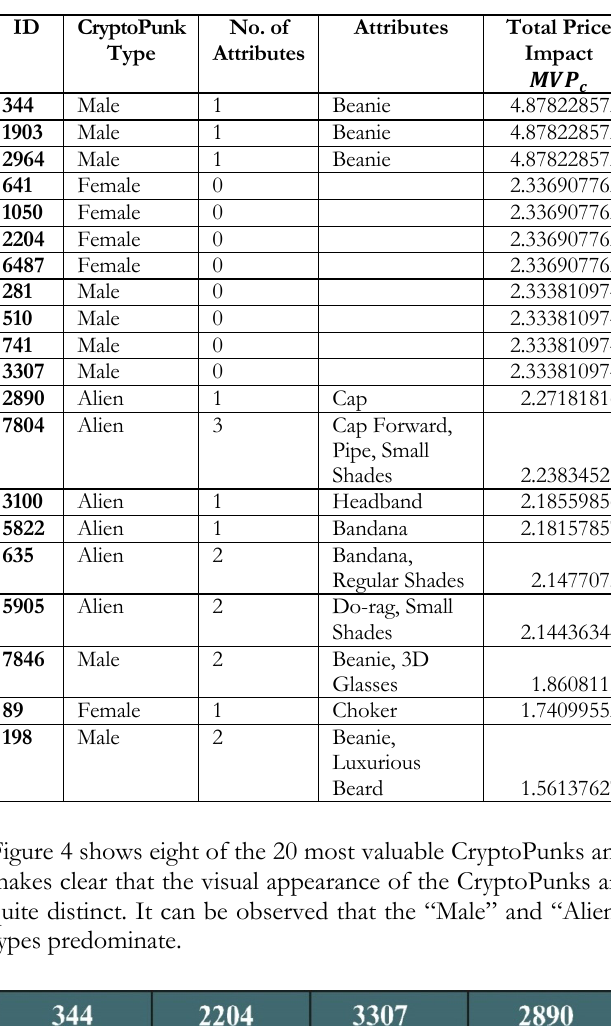
Table 7: Most Valuable CryptoPunks